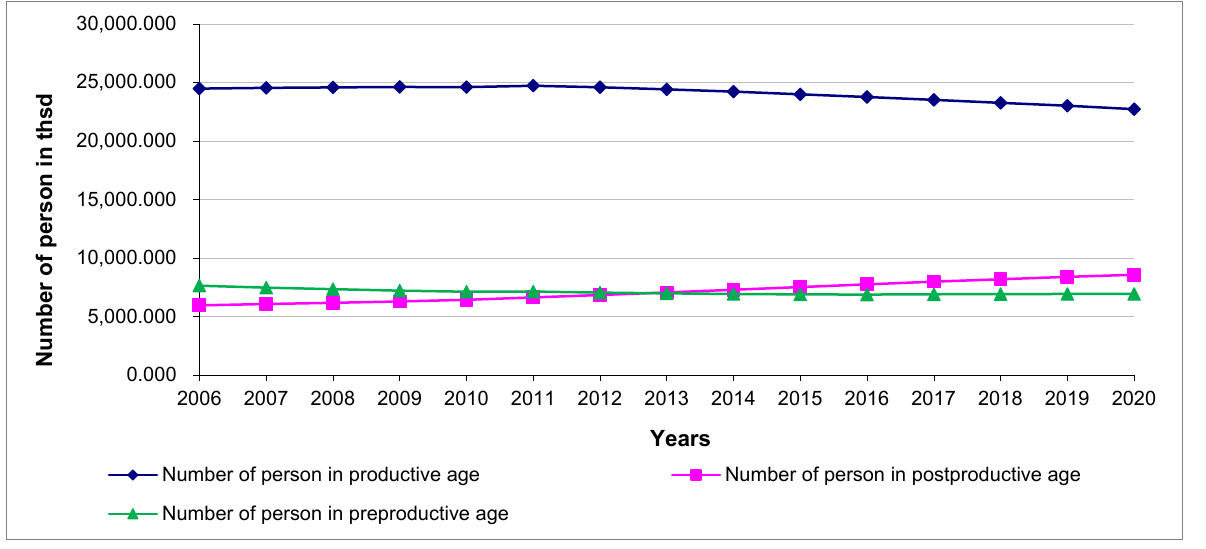
Figure 5. Number of people of pre-, post-, and productive age (in thsd, 31.12). Source: Own calculations based on data from the Central Statistical Office.